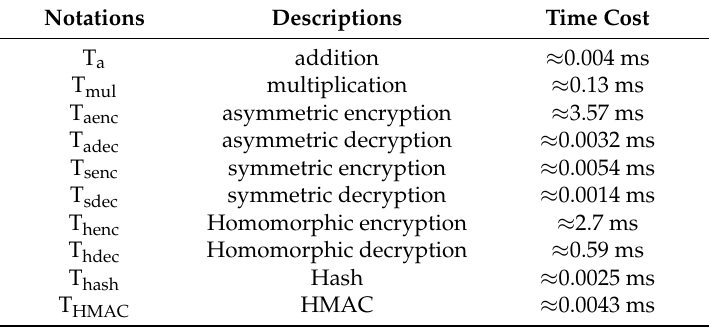
Table 2. Experiment measured average time for each